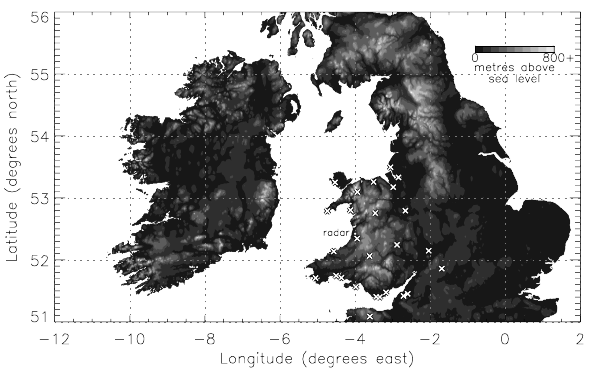
Fig. 1. Land height of the area for Figs. 2, 3, 5a, b, d–f, 6, 11. × shows 26 surface weather sites for Figs. 8–10; “radar” is location of VHF and UHF radars for Figs. 4, 7–10,